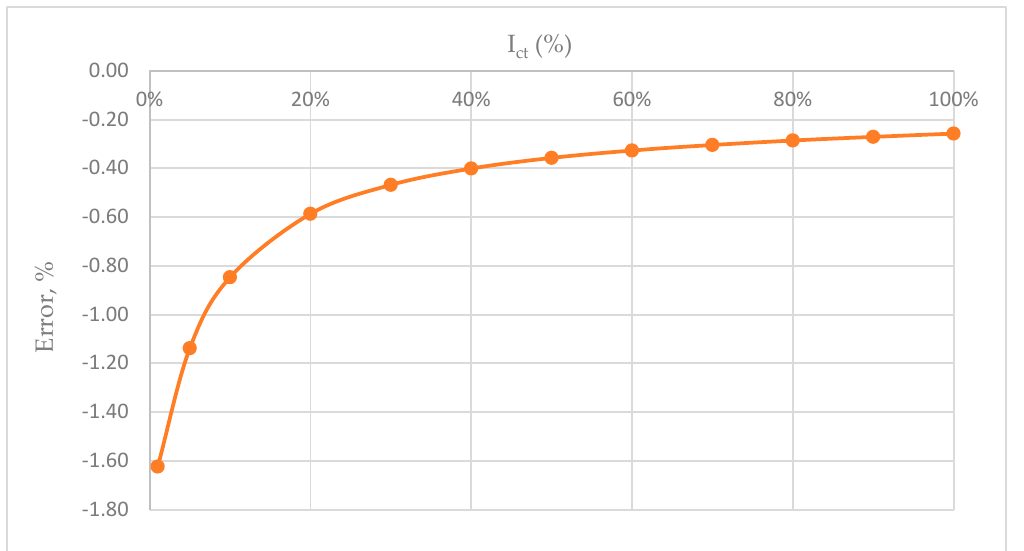
Figure 8. CT error function diagram.